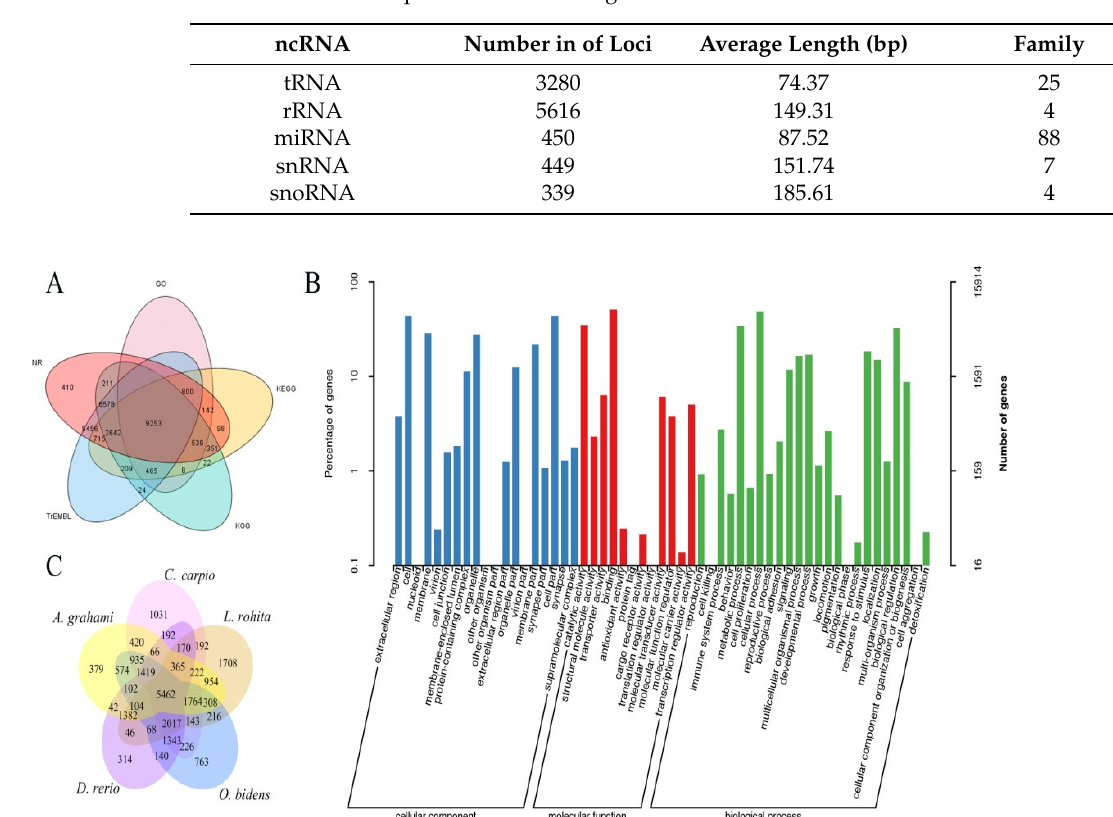
Table 2. Overview of predicted non-coding RNAs.